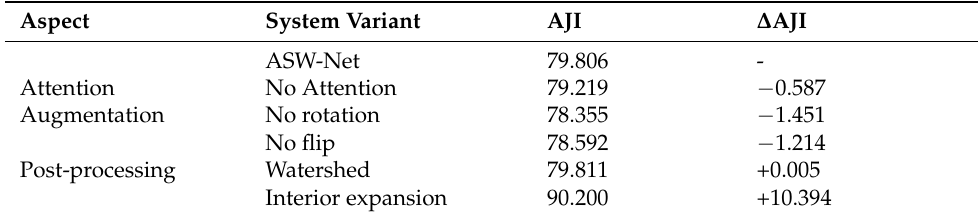
Table 4. Ablation study of